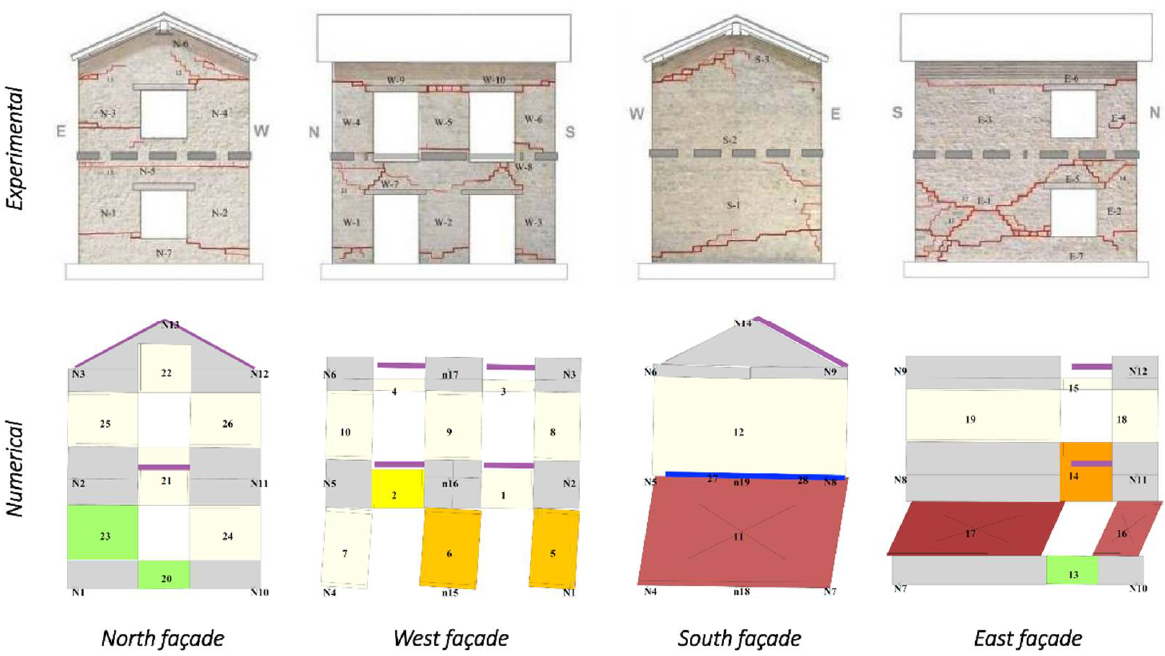
Figure 13. Comparison between experimental and numerical damage patterns for Building 2 (with magnified lateral displacements).